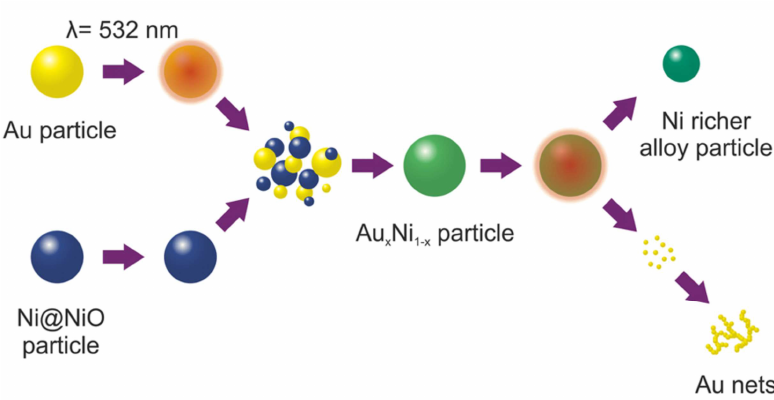
Figure 9. Alloy nanoparticle formation by LML after mixing different nanoparticle colloidal solu- tions [52]. Reprinted with permission from Ref. [52]. Copyright 2016 American Chemical Society.